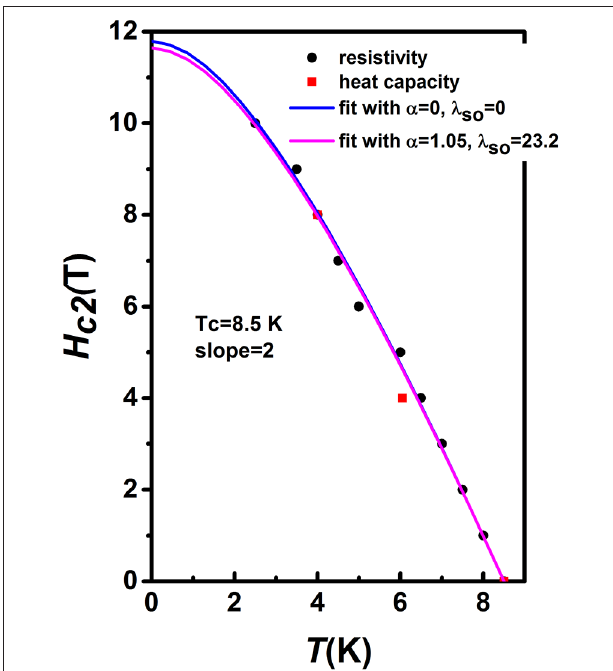
FIGURE 5 | The upper critical field H c 2 from resistivity (black circles) and from specific heat measurements (red squares) as a function of temperature for the Ti 15 Zr 15 Nb 35 Ta 35 HEA. The blue and pink lines are the WHH predictions with the parameter α 0, λ so 0, and α 1.05, λ so 23.2, respectively. = = = =